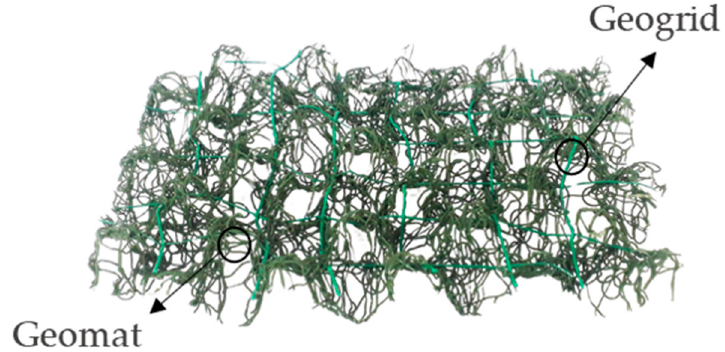
7 of 17 ( b ) Figure 4. Schematic configuration profile of erosion control techniques: ( a ) geomat and ( b ) geomat and sack gabion. 2.3. Geomat Characteristics The geomat used to control the erosion on the reservoir’s margins is a three-dimen-